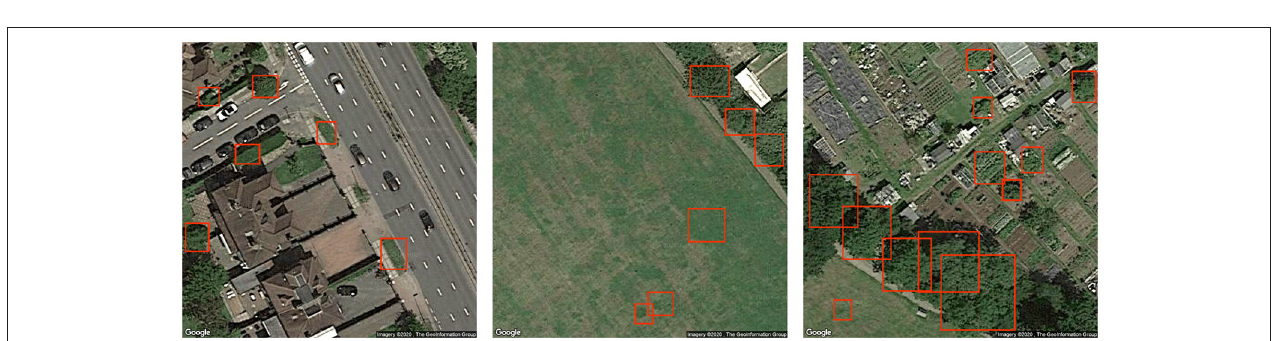
FIGURE 3 | Positive results with self supervised model (trees in red bounding boxes).